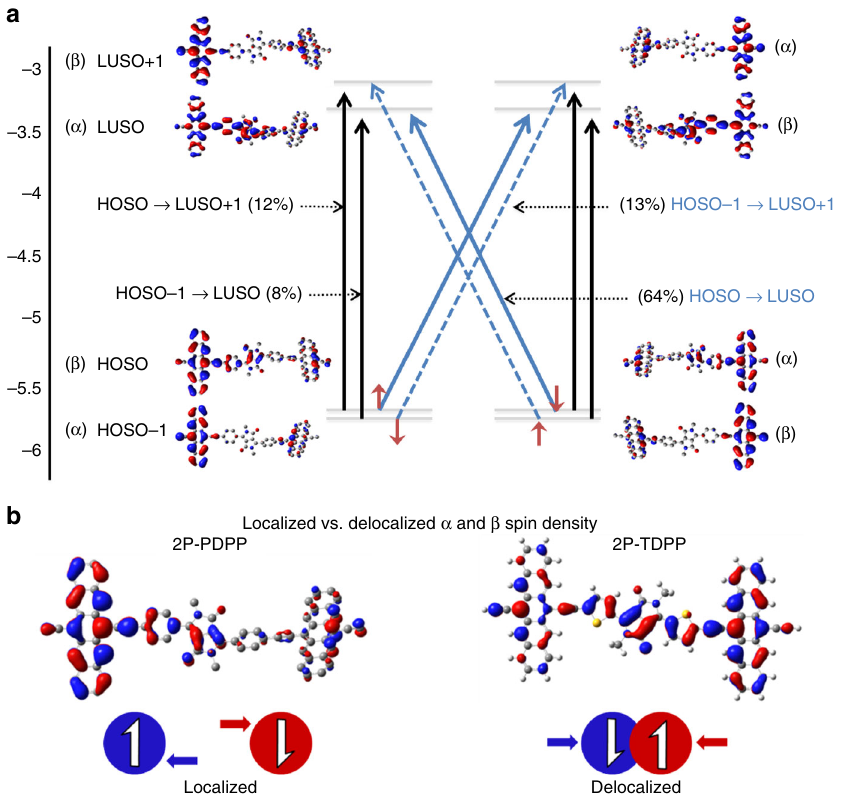
Fig. 3 Contributions of orbital replacements and spin density comparison. a The electron density change between ground and excited state arises from a linear combination of orbital replacements with CT (blue arrows) and LE (black arrows) character. The HOSO to LUSO transition which contributes strongest (64%), has CR character, moving the α -electron from left to right and the β -electron from right to left. This leads to a partial 1 TT character of S 1 . b α -HOSOs of 2P-PDPP and 2P-TDPP (the symmetry equivalent β -orbitals are omitted). In 2P-PDPP α - and β -electrons are spatially separated because the SOs are polarized towards opposite pentacenes. In 2P-TDPP the SOs of α -and β -electrons are less polarized and involve the bridge more